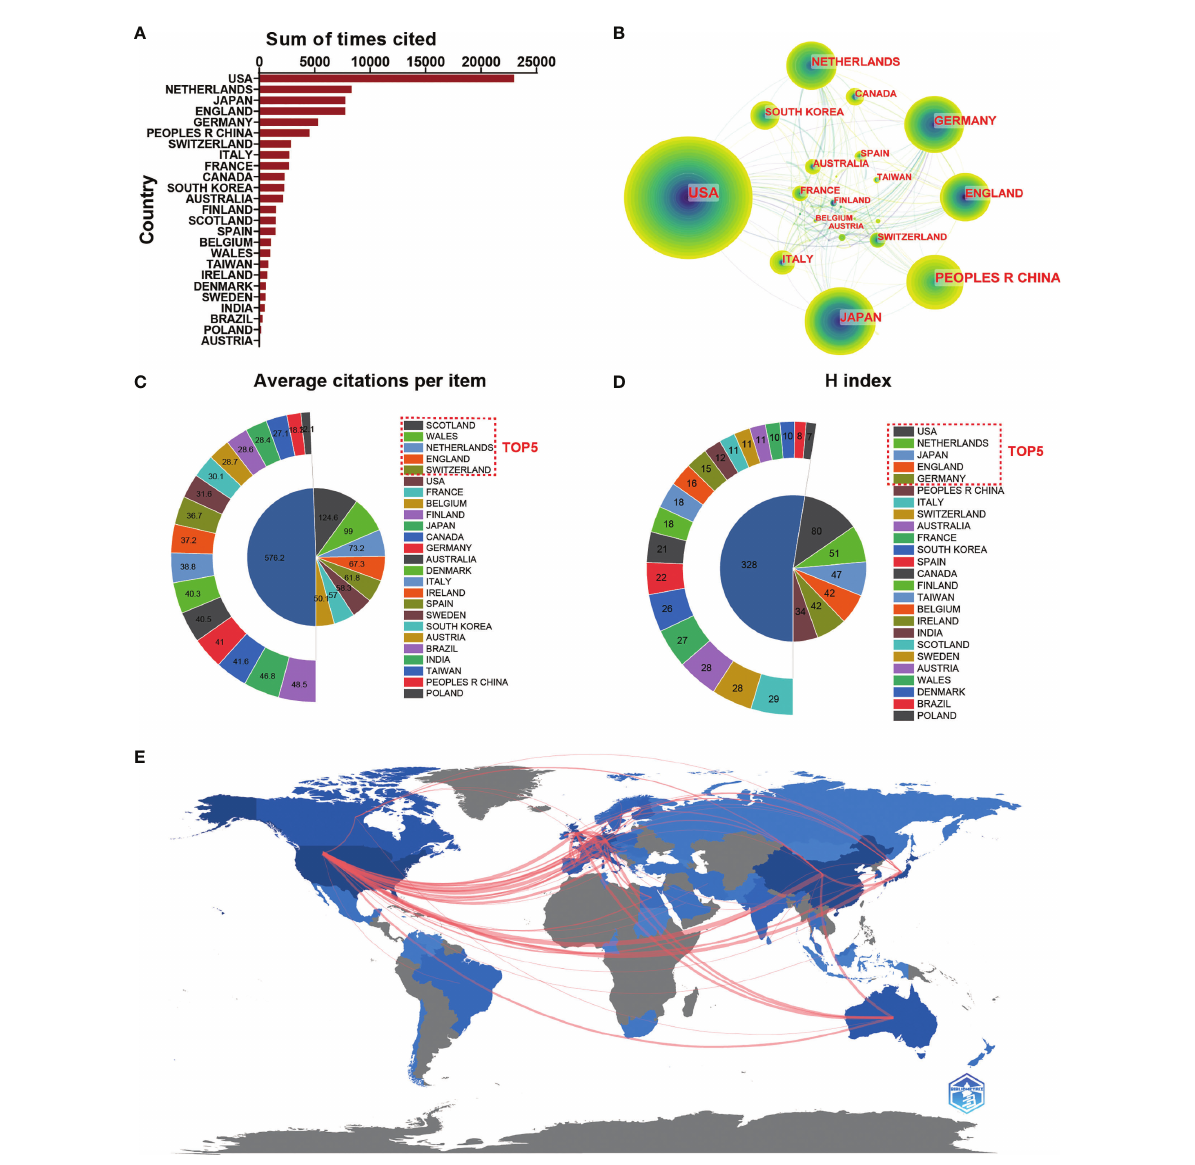
FIGURE 3 (A) The top 25 countries/regions of total citations related to macrophages associated with osteoarthritis. (B) Country/regional collaboration analysis. (C) The top 25 countries/regions of the average citations per publication related to macrophages associated with osteoarthritis. (D) The top 25 countries/regions of the publication H-index related to macrophages associated with osteoarthritis. (E) The geographical network map of macrophages associated with